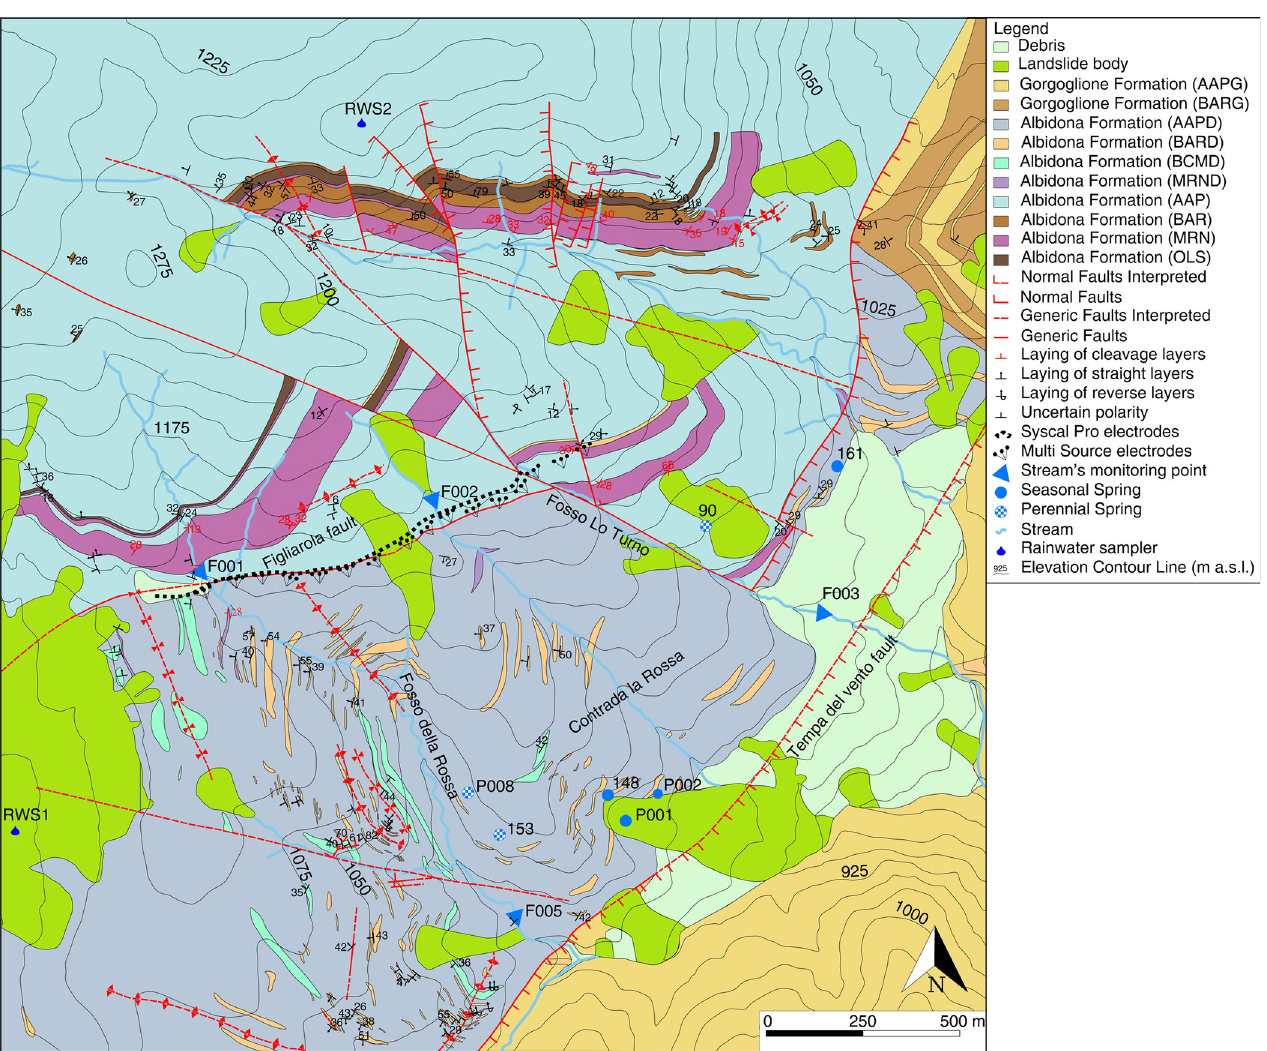
Fig 3. Geological map, geophysical investigation, and monitored springs/streams. After Prosser et al. [26],